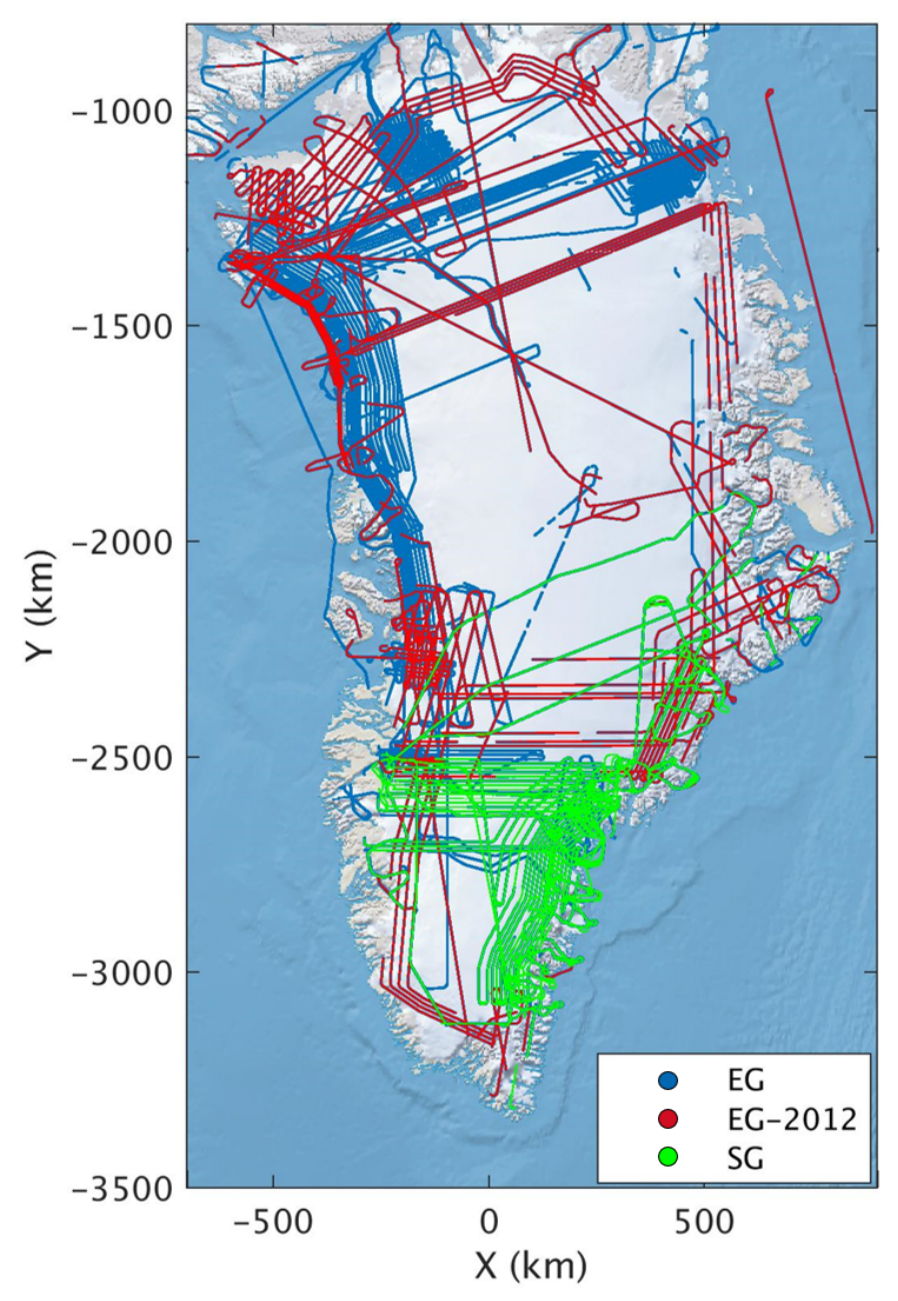
Figure 2. Map showing the flight paths where the airborne Snow Radar was flown to capture the